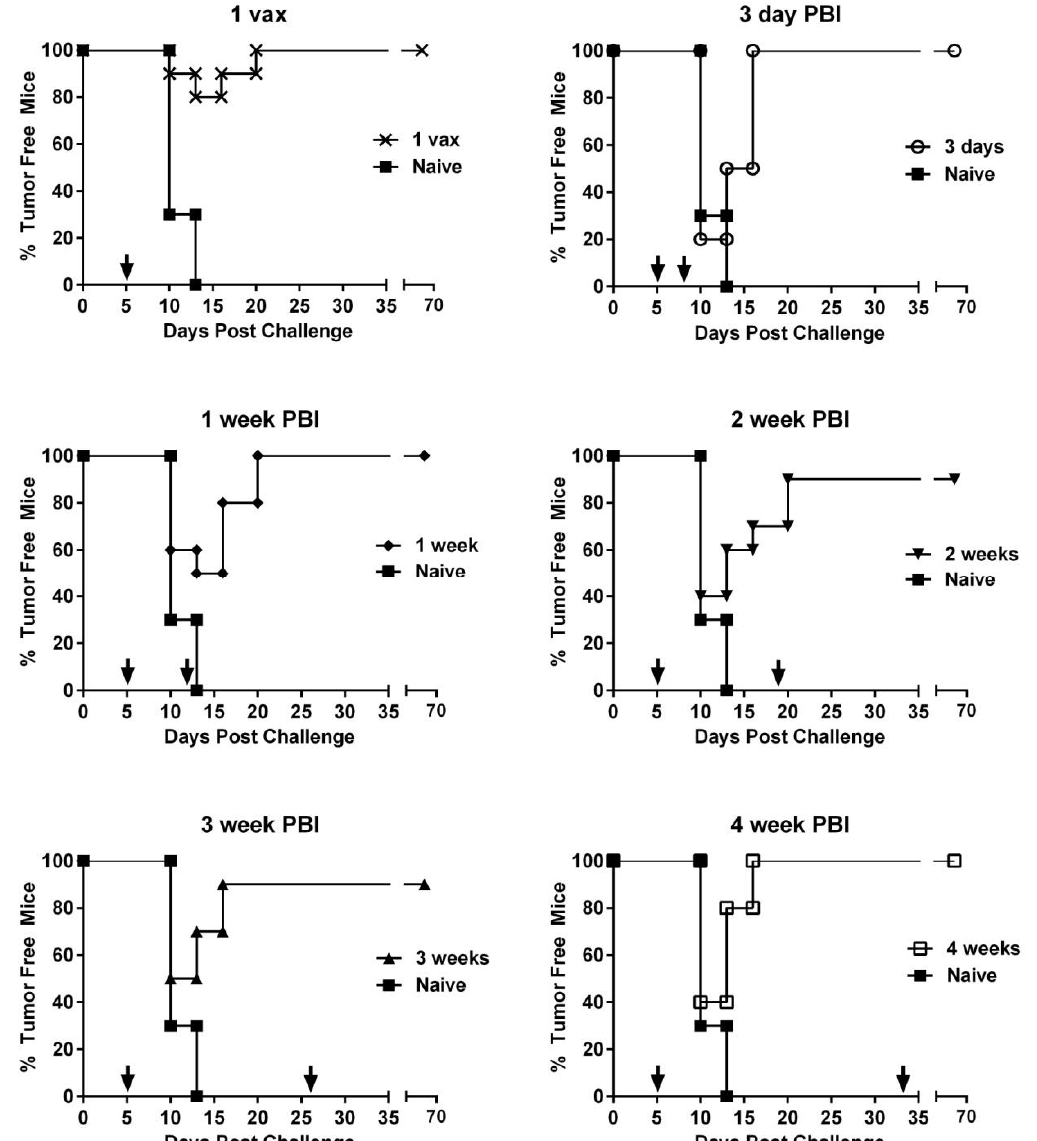
Figure 5. Timing of prime-boost interval does not impact therapeutic efficacy of VRP-based vaccine. C57BL/6 mice ( n = 10/group) were challenged with 5 × 10 5 C3.43 tumor cells s.c. in the flank. Mice were immunized i.m. with HPV16 E6E7 VRP at increasing PBIs starting on day 5 post tumor challenge. Vaccinations are indicated by arrows. Each group is graphed individually against naïve, unvaccinated mice. All vaccinated groups were significantly protected compared to naïve group ( p < 0.0001, log-rank test).